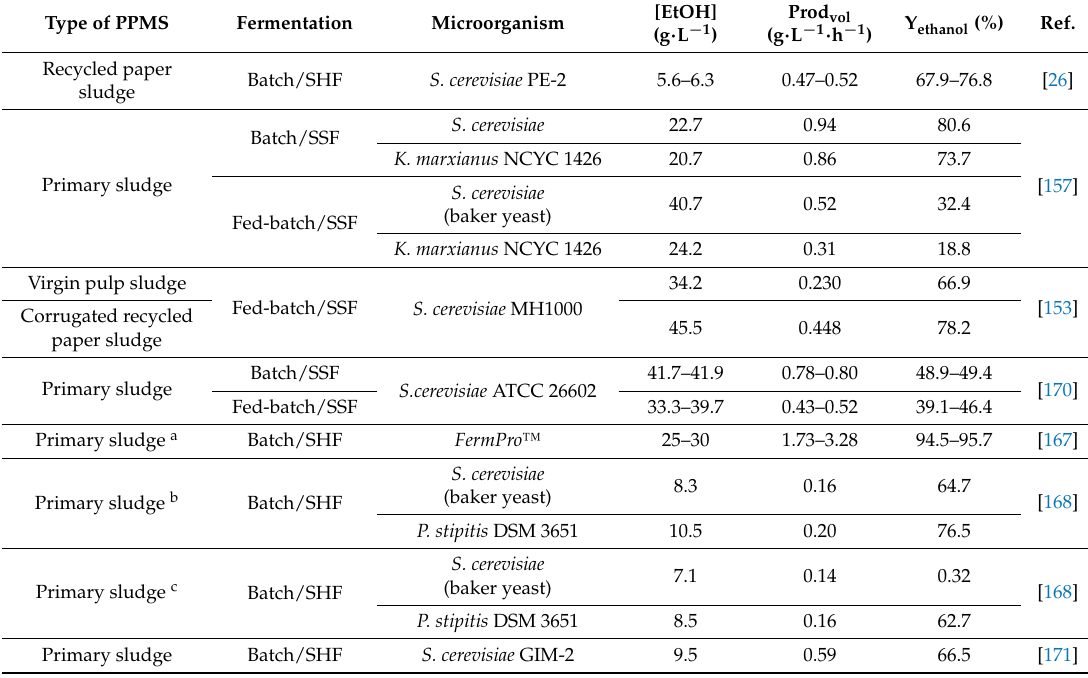
Table 5. Pulp and paper mill sludge for bioethanol